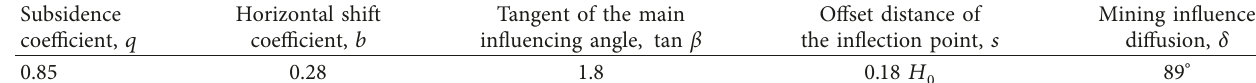
Table 2: Prediction parameters of mining subsidence provided by mine owners.